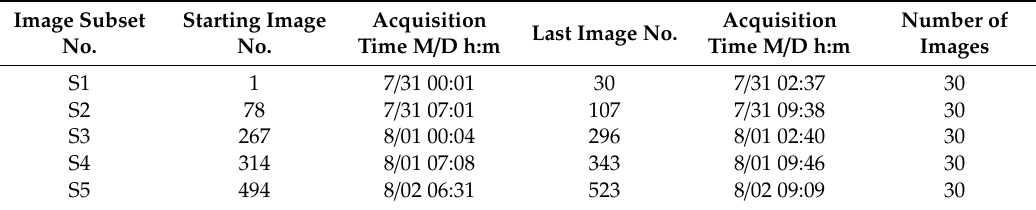
Figure 7. Interferometric phase series and unwrapped phase series of a high-TSNR pixel in the Geheyan dam area: ( a ) interferometric phase series of adjacent images; and ( b ) unwrapped phase series, where S1, S2, S3, S4, and S5 are the five selected image subset periods. Table 2. Selection of continuous images in image subsets.